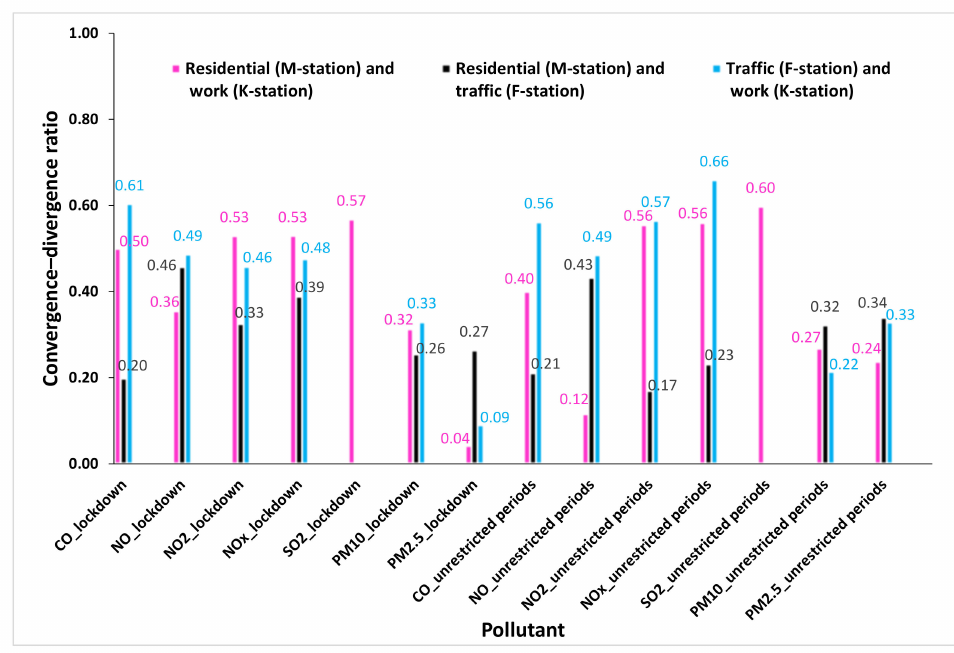
Figure 2. The degree of similarity or discrepancy in the air pollutant concentrations among the selected residential, traffic, and work sites during the selected study